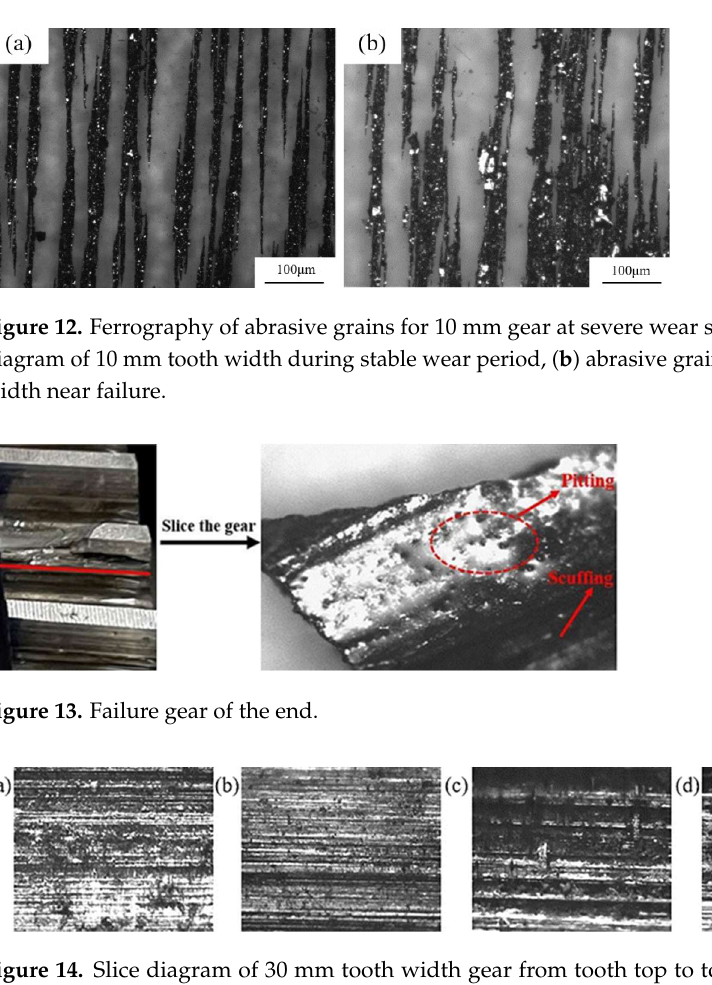
Figure 11. Variation trend of abrasive particle concentration for 10 mm gear until failure.